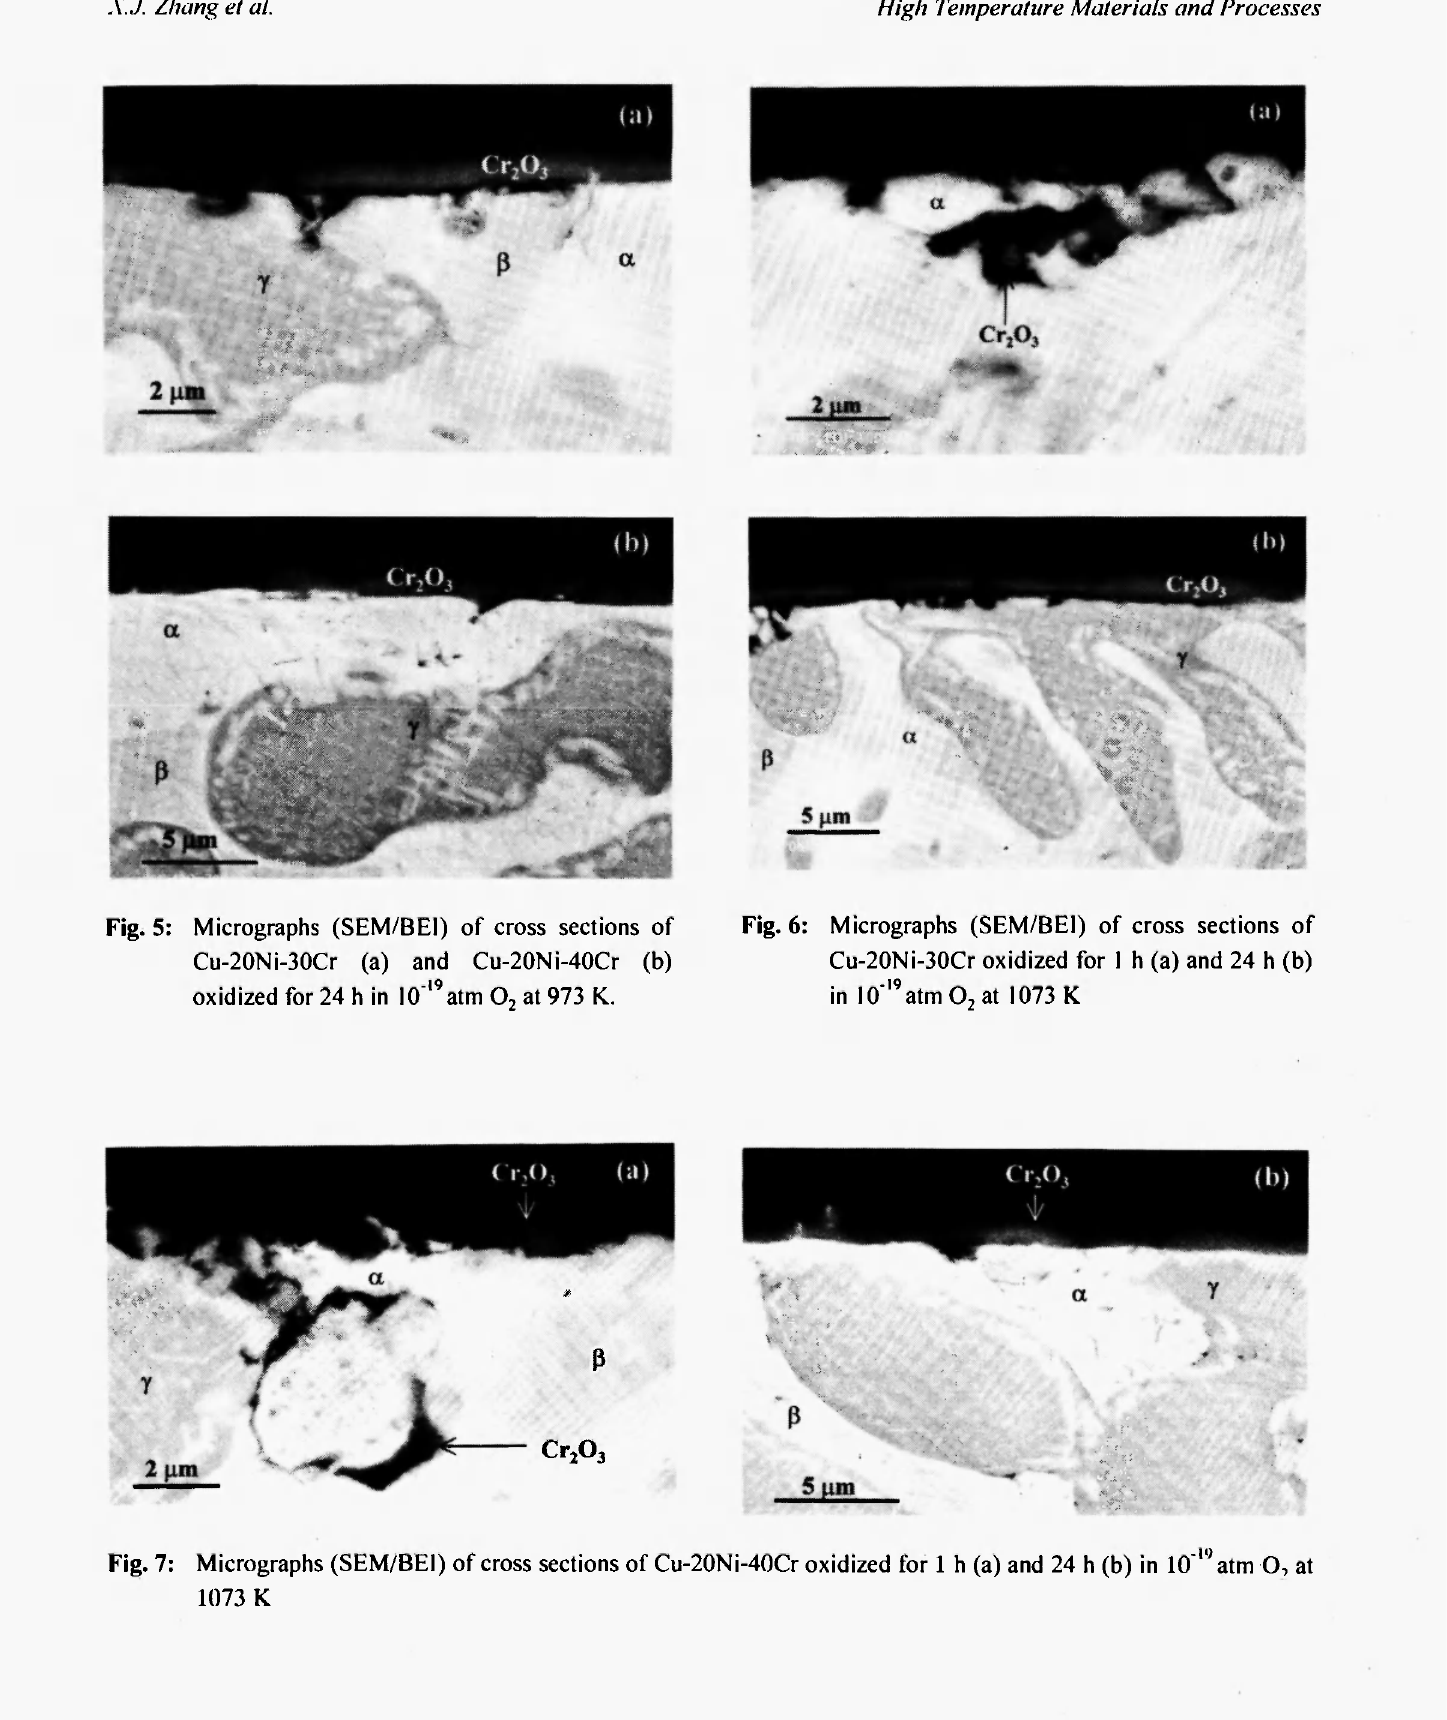
Fig. 7: Micrographs (SEM/BEI) of cross sections of Cu-20Ni-40Cr oxidized for 1 h (a) and 24 h (b) in 10"'''atm O, at 1073 Κ